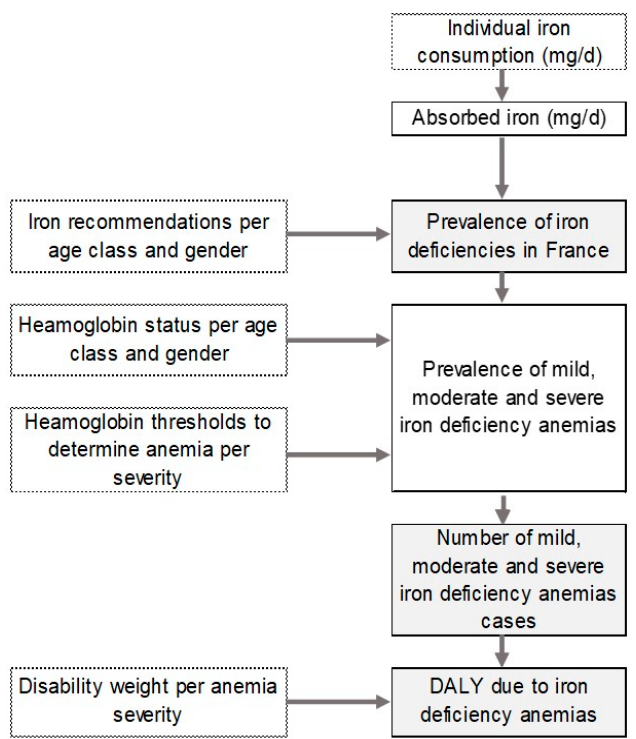
Figure 1. Flowchart of the assessment model of iron deficiency anemia disease per year in France per age class and gender. White rectangles with dashed line correspond to the “Inputs”, full line to “Intermediate calculation”. Light grey rectangles correspond to the “Final output”. Absorbed iron corresponds to the mean absorbed values provided by European Food Safety Authority (EFSA) considering both heme and non-heme iron.